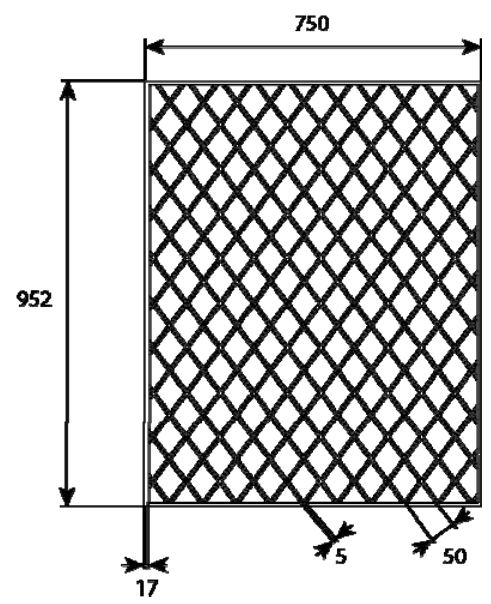
Fig. 5. The splash (grid) fill with the rhombus shape bars .